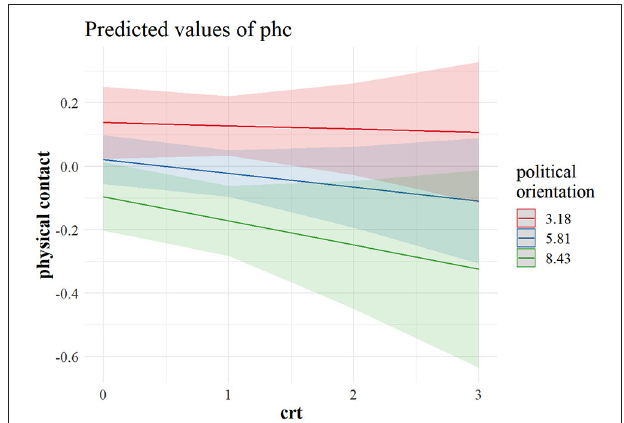
FIGURE 5 | Marginal predicted values for avoiding physical contact from a model interacting CRT and political orientation in the US sample ( n = 905). The predictor values for left (3.18), centrist (5.81), and right (8.43) political orientation are ± 1 SD . CRT values (0–3) indicate the number of correct responses. phc, avoiding physical contact; crt, cognitive reflection.